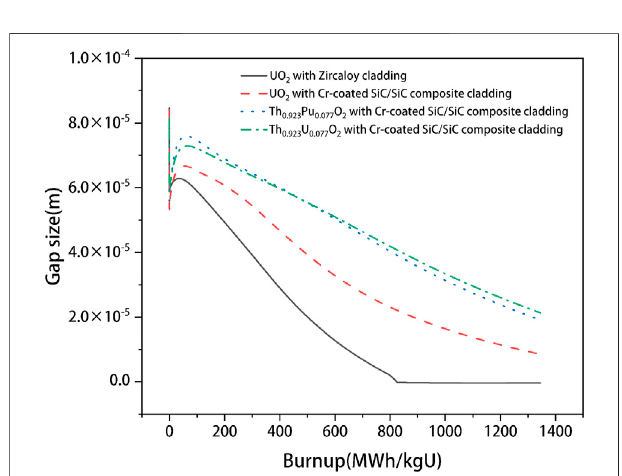
FIGURE 12 | Plenum pressure evolutions for the UO 2 fuel with Zircaloy cladding, the Th 0.923 Pu 0.077 O 2 fuel, and Th 0.923 U 0.077 O 2 fuel with Cr-coated SiC/SiC composite cladding under the normal operating condition.